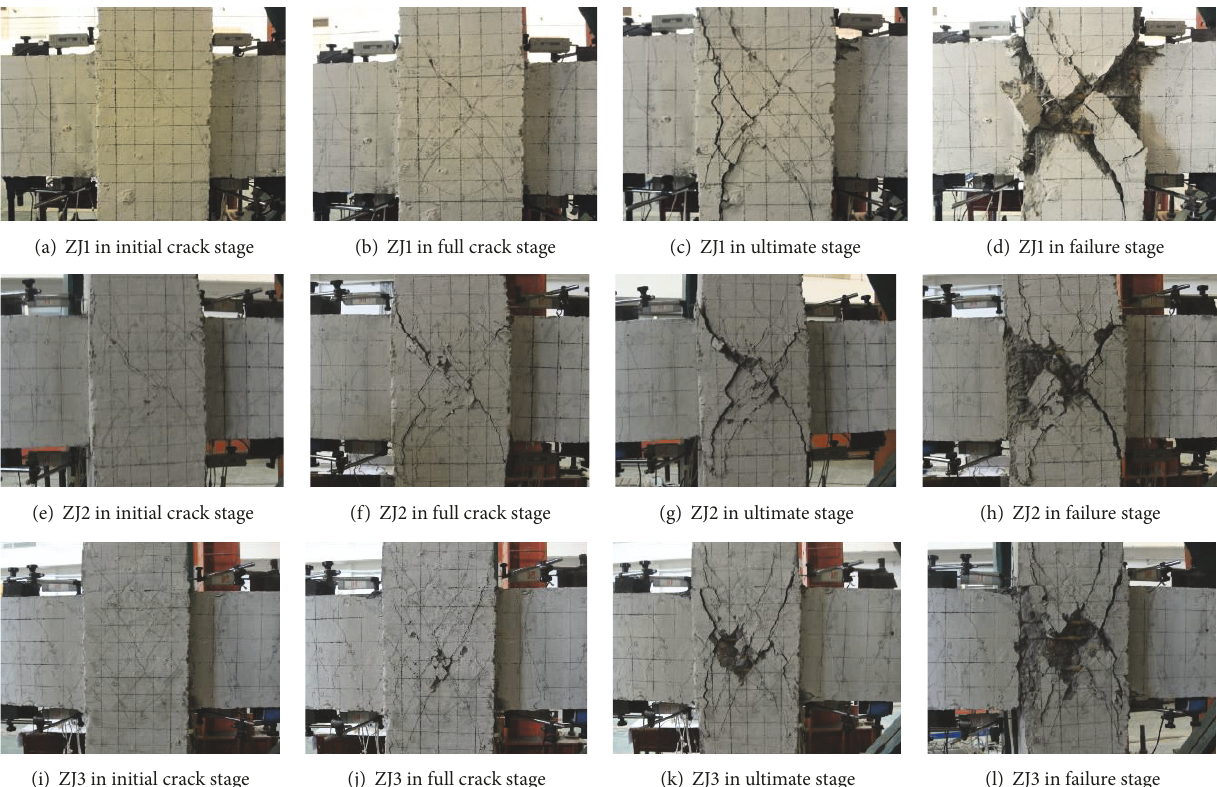
Figure 4: Damaged state of specimens in joints core